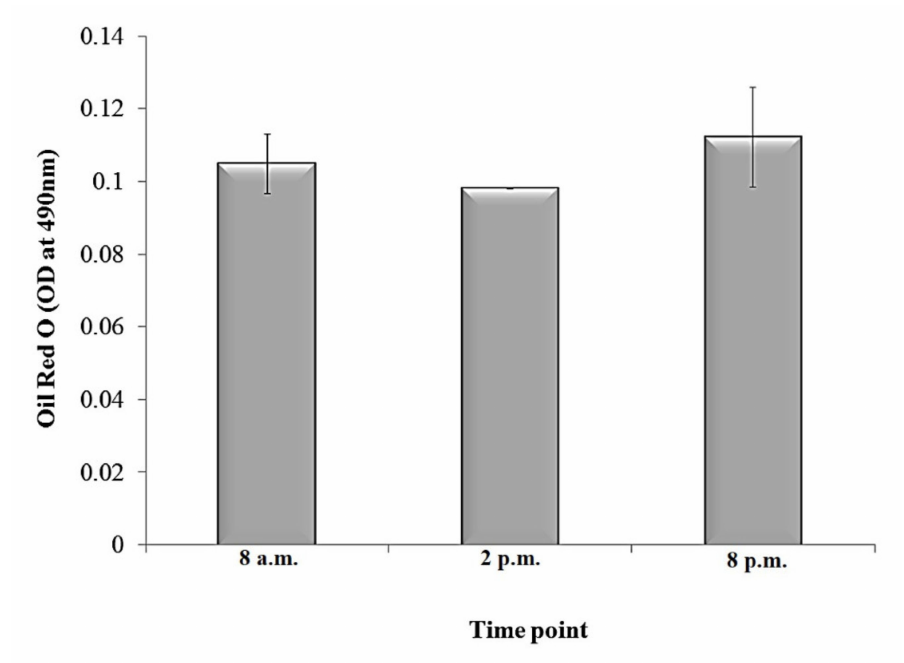
Figure 4. Spectroscopy quantification at 490 nm of Oil Red O stain extracted from stained leaf